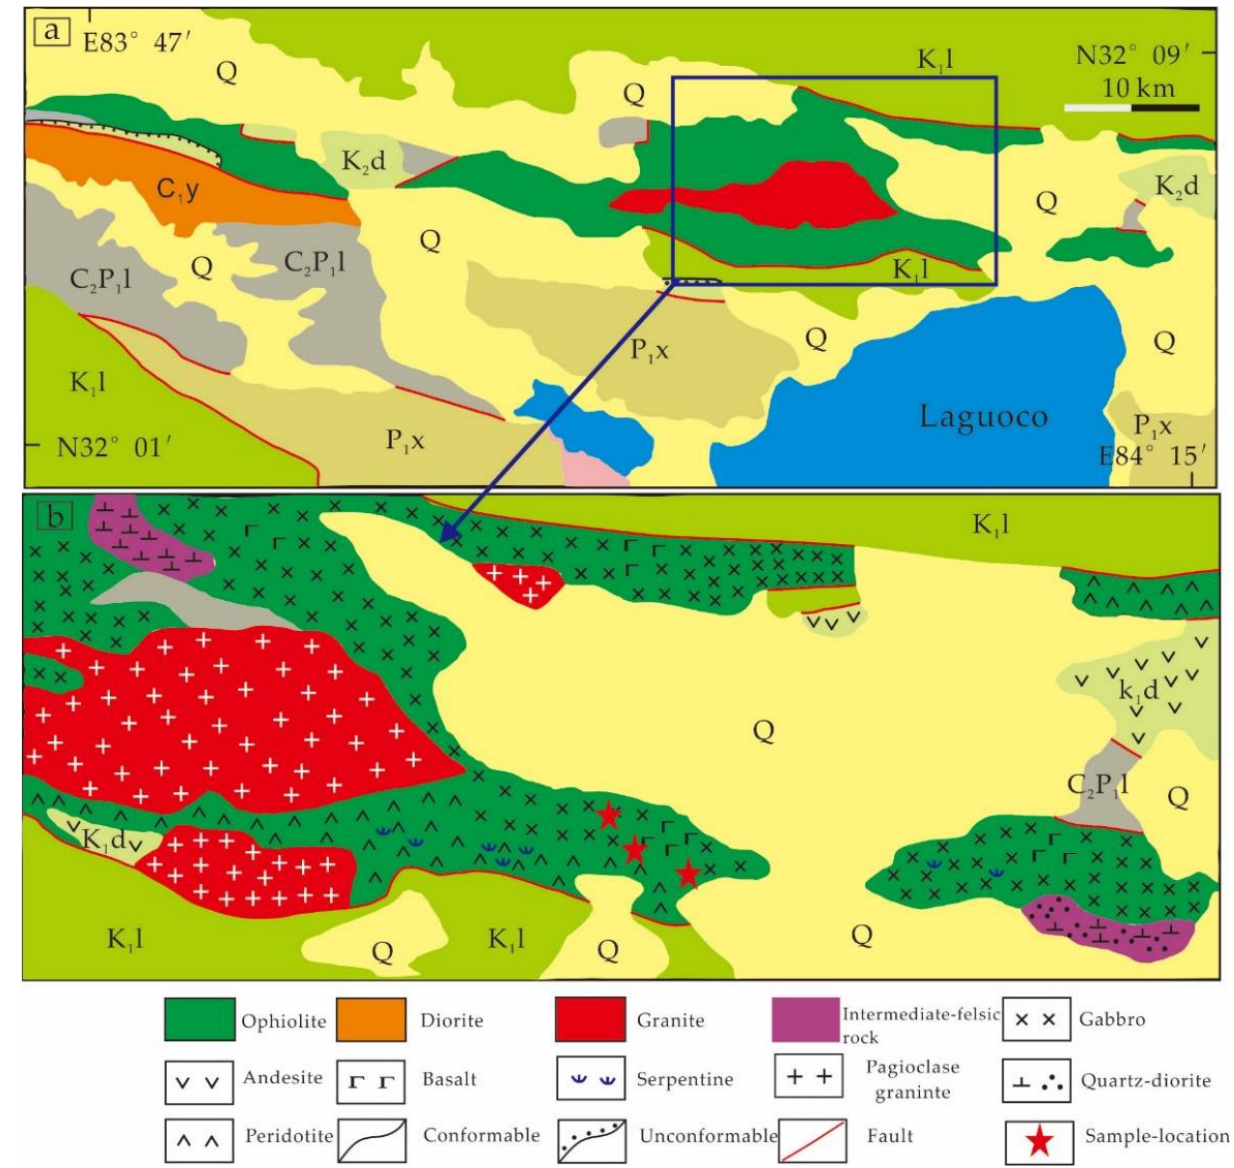
Figure 2. ( a ) Main geotectonic units of Laguoco. ( b ) Simplified geologic map of the Laguoco ophiolite, modified after [12]. C 1 y: Early Carboniferous Yongzhu formation; C 2 P 1 l: Late Carboniferous– Early Permian Laga Formation; P 1 x: Early Permian Xiala Formation; K 1 l: Early Cretaceous Lanon Formation; K 1 d: Early Cretaceous Duoni Formation; Q: Quaternary.